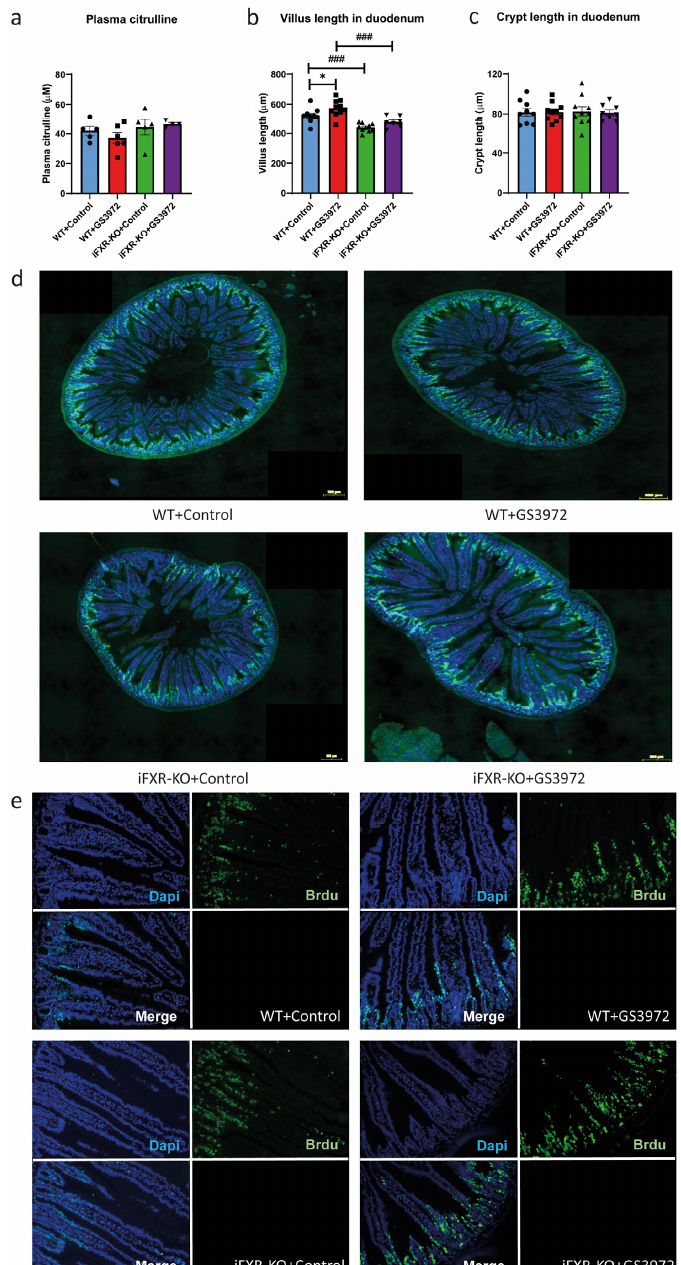
Figure 5. Activation of FXR does not lead to increased proliferation rate of epithelial cells in duode- num ( a ) Plasma citrulline level from WT and iFXR-KO mice wild-type (WT) and intestine-specific FXR − / − (iFXR-KO) mice treated with or without GS3972 for one week under high-fat-diet (HFD) condition. ( b ) Quantified analysis of villus length and ( c ) crypt length of duodenum from WT and iFXR-KO mice treated with or without GS3972 for one week under HFD (10 villi were selected from each mouse for qualification). ( d , e ) Representative image of immunofluorescence staining for the proliferative cell marker Brdu in duodenum from WT and iFXR-KO mice treated with or without GS3972 for one week under HFD. ( d ) Image of whole section of duodenum captured by TissueFax (magnification 10 × ; bar represents 200 µ m). ( e ) Image of part section of duodenum captured by the digital camera (magnification 16 × ). Statistical significance was determined using Kruskal–Wallis H-test followed by post-hoc Conover pairwise comparisons. Panel ( a ): n = 4–6/group; Panel ( b – e ): n = 7–9/group. Data are represented as mean ± SEM, * p < 0.05 when mice with GS3972 treatment compared with control, ### p < 0.001 when iFXR-KO mice compared with WT